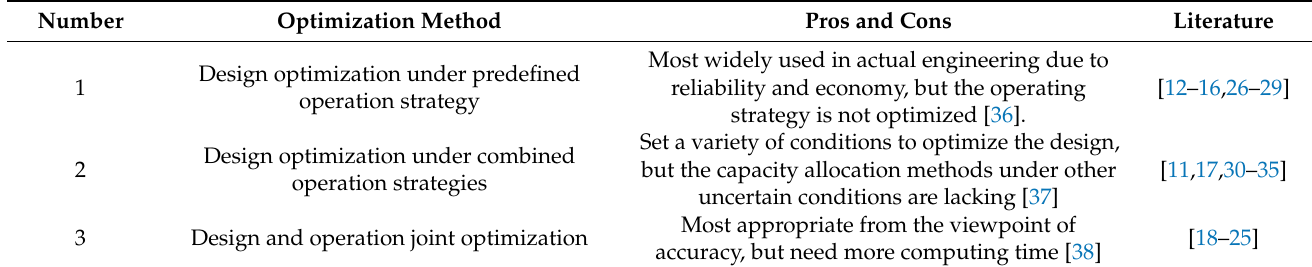
Table 1. Comparison between design optimization methods for hybrid energy